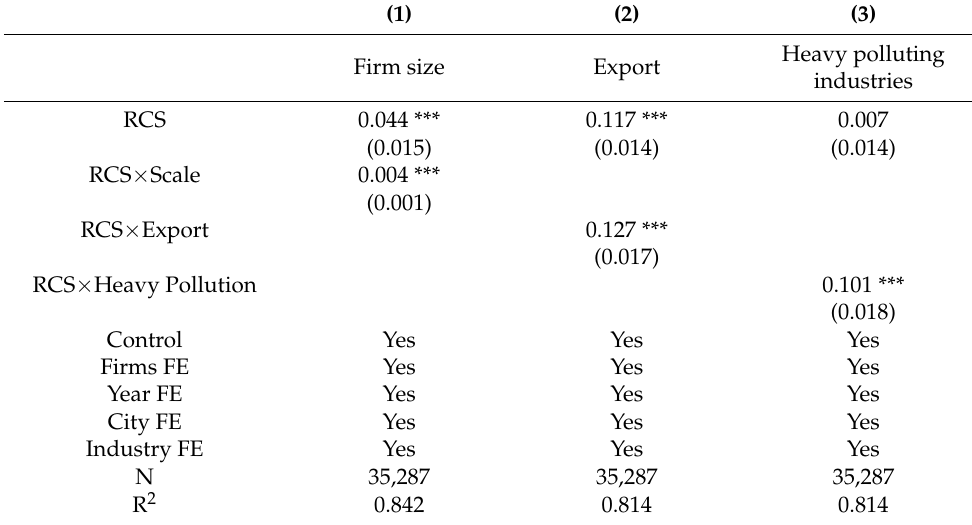
Table 7. Heterogeneity